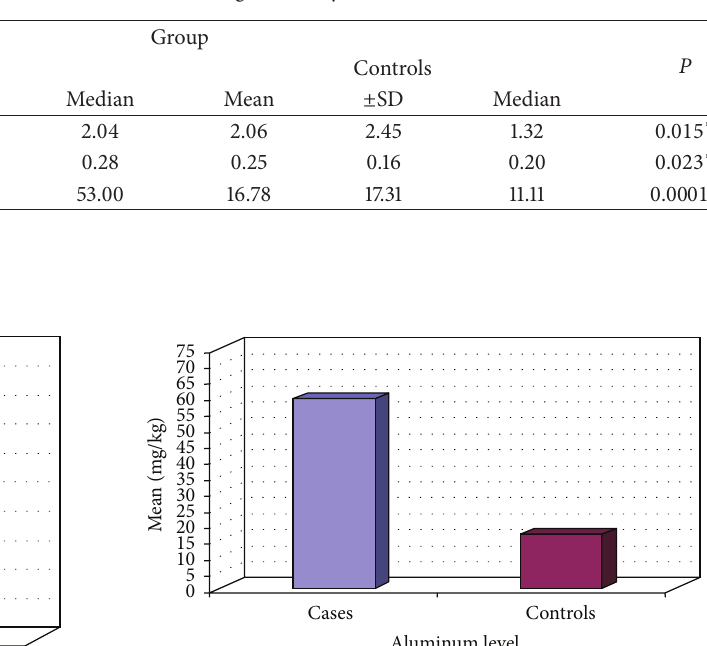
Table 3: Comparison between cases and controls as regards heavy metal levels.